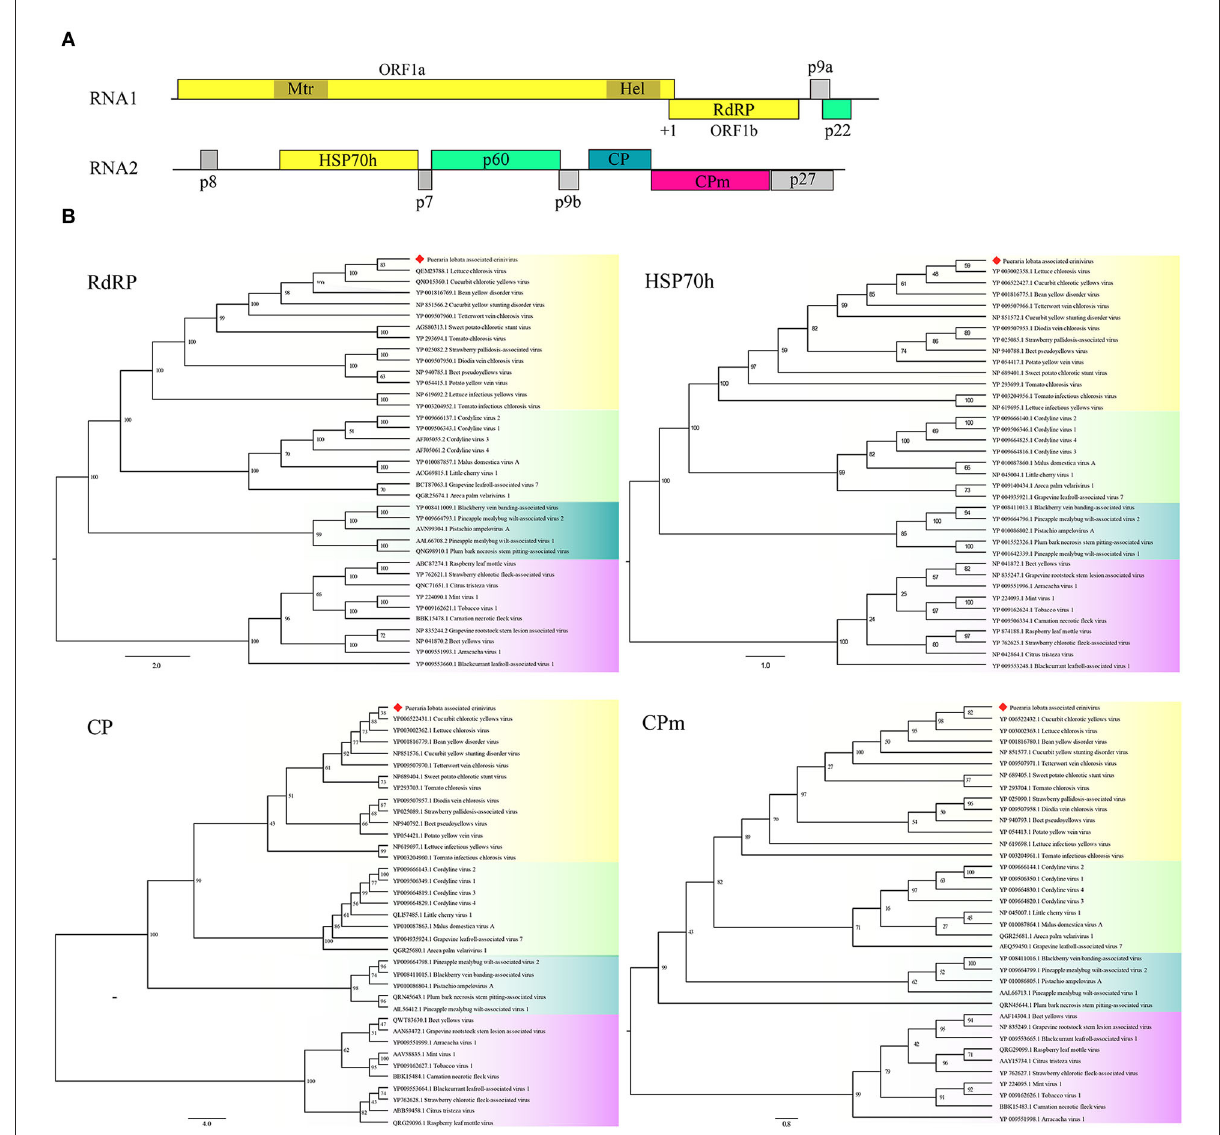
FIGURE3 Genome and phylogenetic analysis of Pueraria lobata -associated crinivirus (PloACV) identified in P. lobata . (A) Schematic representation of the PloACV. The genomic RNA1 and RNA2 are presented by a line, with the ORFs indicated by colored boxes. ORFs are shown above or below the line, indicating that they are found in different reading frames. On RNA1, + 1 indicates a putative + 1 ribosomal frameshift site. Methyltransferase domain (Mtr) and RNA helicase domain (Hel) were predicted in ORF1. (B) Phylogenetic analysis of the amino acid sequences deduced for the RdRP, HSP70h, CP, and CPm of criniviruses (yellow boxes), velariviruses (pale green boxes), ampeloviruses (dark green boxes), and closteroviruses (red boxes) in family Closteroviridae . GenBank accession number of each sequence is shown. Bootstrap values are indicated at the nodes.